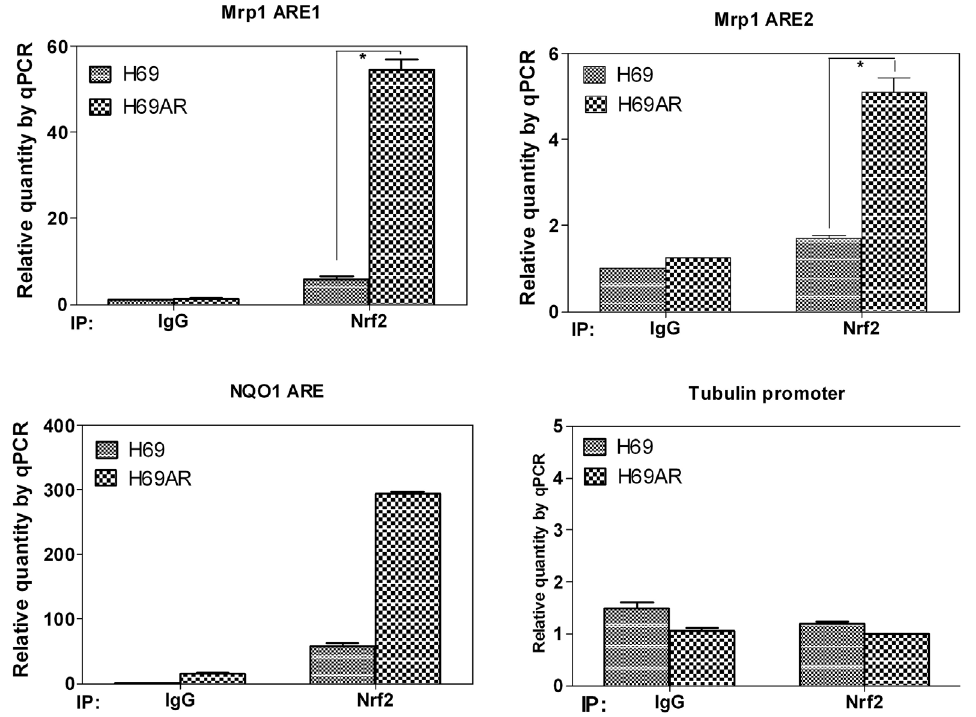
Figure 5. Nrf2-mediated induction of Mrp1 promoter activity depends both on ARE1 and ARE2 in small cell lung cancer cells. H69 and H69AR cells were cross-linked with formaldehyde. Sonicated chromatin was subjected to immunoprecipitation with antibodies against Nrf2 or normal IgG. Precipitated DNA was followed by realtime PCR analysis with primers against Mrp1 ARE1 (panel A), Mrp1 ARE2 (panel B), NQO1 ARE (panel C) and Tubulin promoter (panel D). Experiments were performed three times and a representative of three experiments was shown here.